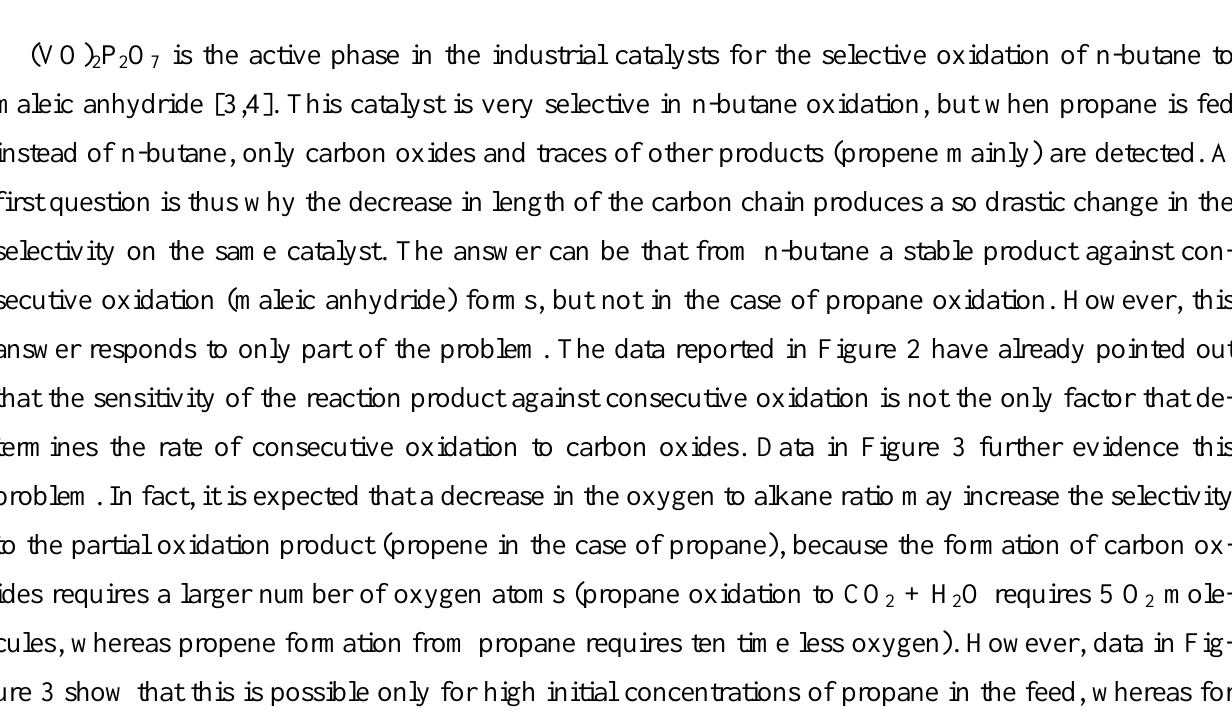
Figure 3. Selectivity in propene formation from propane on (VO) ratio between oxygen and propane concentrations, for two initial concentrations of propane in the feed. Reaction temperatures: